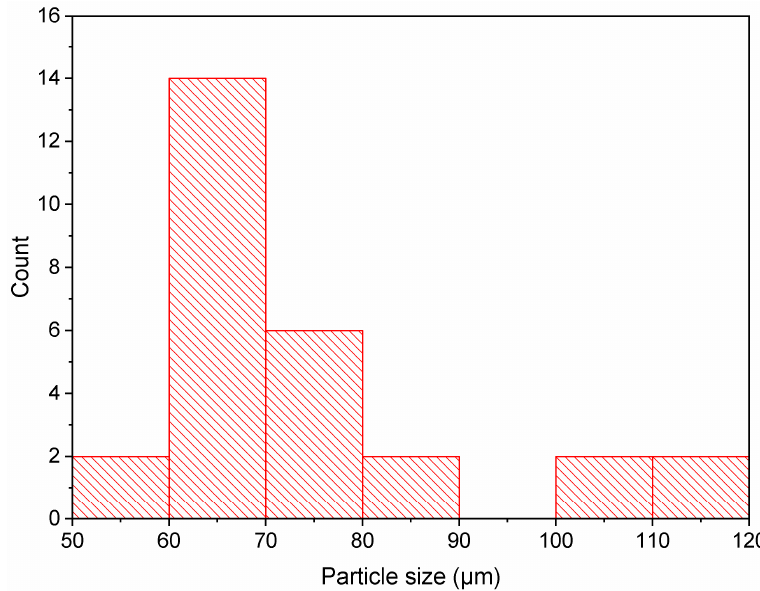
Figure 13. Particle size distribution.